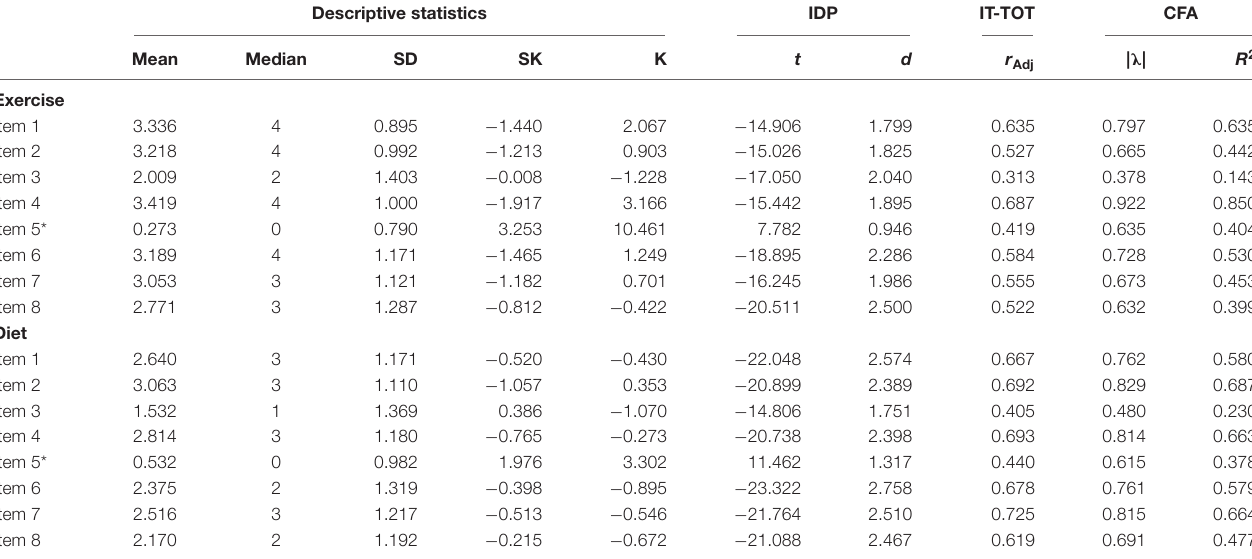
TABLE 2 | Item descriptive statistics, item discriminant power (IDP), item–total adjusted correlation (IT-TOT), and confirmatory factor analysis (CFA). Descriptive